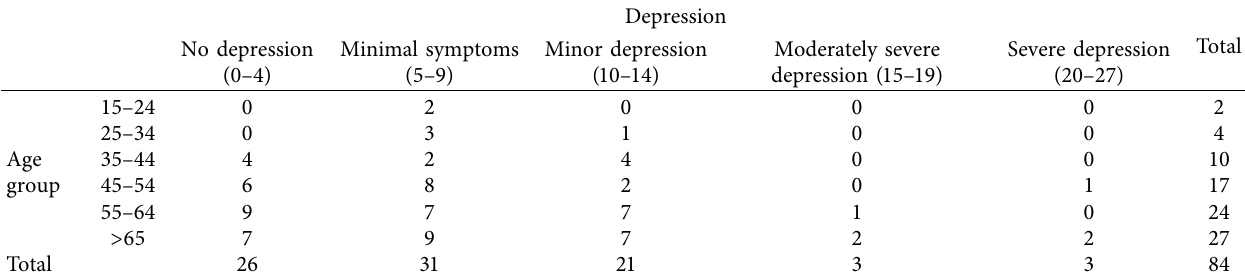
Table 2: Frequency distribution of depression with age group among stroke patients at TASH and ZMH neurology